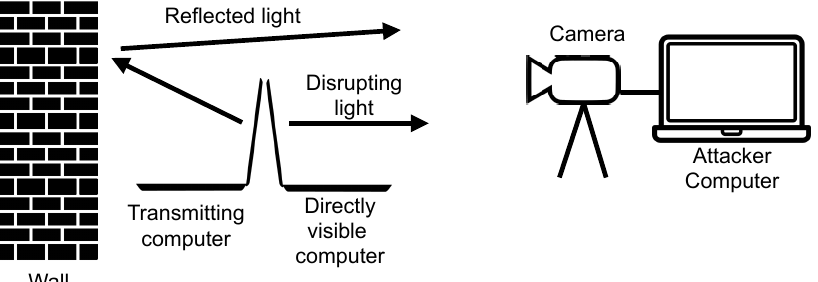
Figure 7. Diagram of a transmission experiment in cluttered